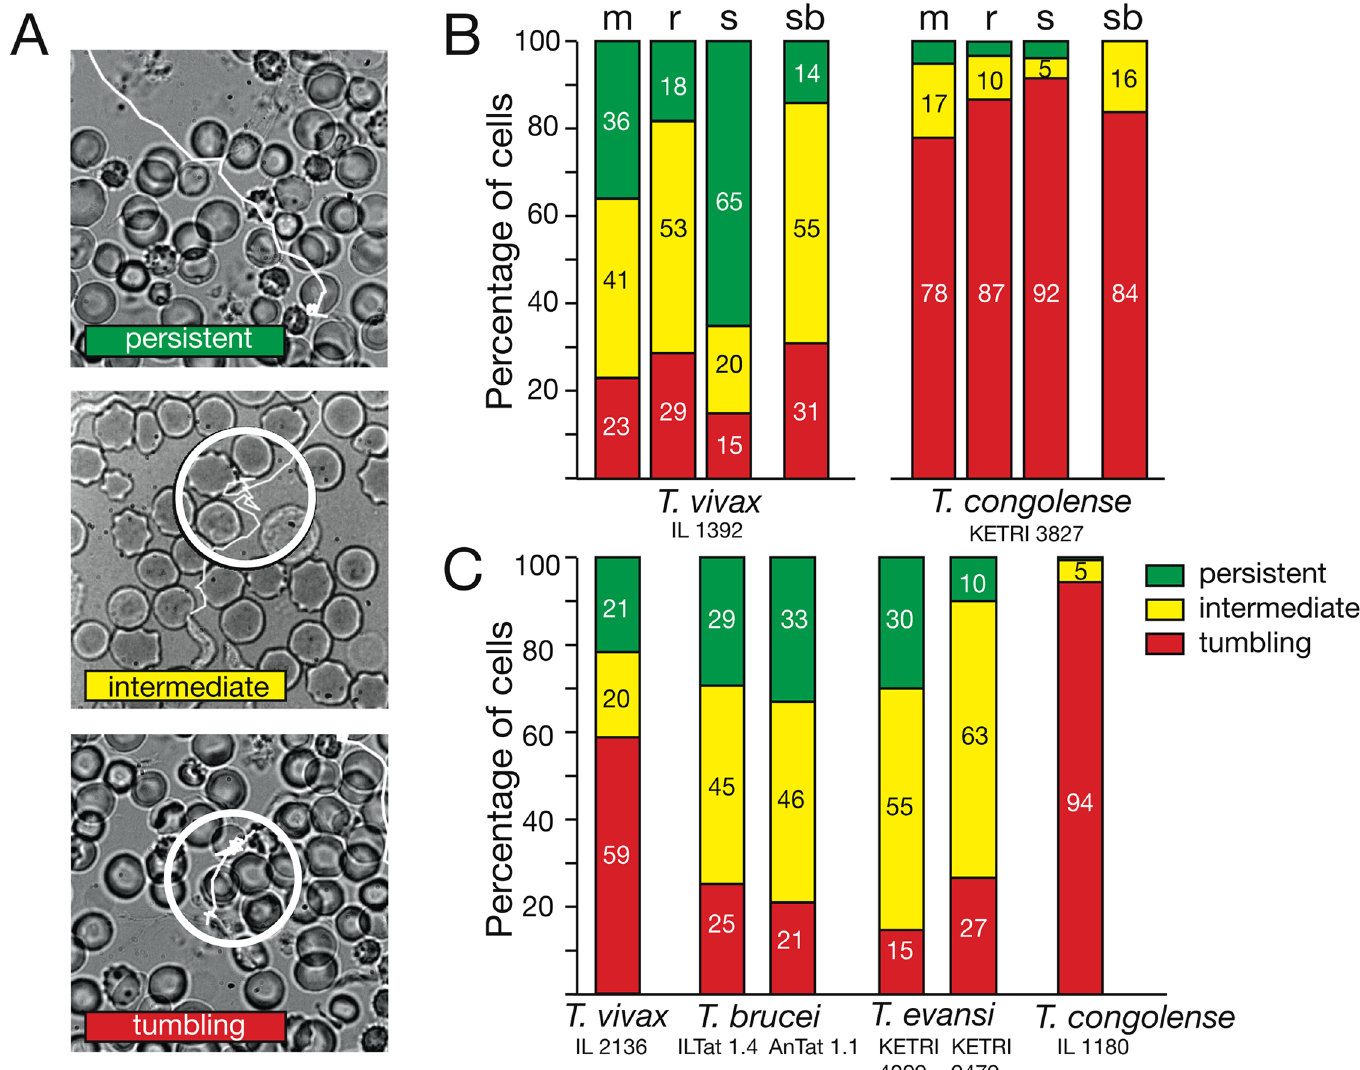
Fig 1. Defined motility patterns characterise the behaviour of trypanosome species in the blood of different hosts. A) Representative examples of three motility types visualised by single cell trajectories. Videos were captured with a frame rate of 500 fps. The swimming paths were traced (white lines), (S1 – S5 Videos). Persistent swimmers were defined as cells that swam without a tumbling phase for the duration of a single on-chip recording period (16 s) of the high speed camera. Within this time, intermediate swimmers exhibited at least one tumbling phase. This is a period of two seconds or longer, in which the cells do not leave a circular area with a diameter of 25 μ m (white circle). Tumbling cells stay within this area for the complete observation period of 16 s. B) Comparative motility analysis of T . vivax and T . congolense in blood freshly harvested from infected mouse (m), rat (r) and sheep (s). The host animals revealed a comparable parasitaemia in the range of 10 7 trypanosomes/ml. For comparison, parasites grown in mice were incubated in sheep blood (sb). C) Comparison of the locomotion behaviour of four trypanosome species in mouse blood. All parasites were isolated from infected mice and analysed in fresh neat mouse blood. At least 300 cells were analysed per infection and the motility types were scored as shown in (A).